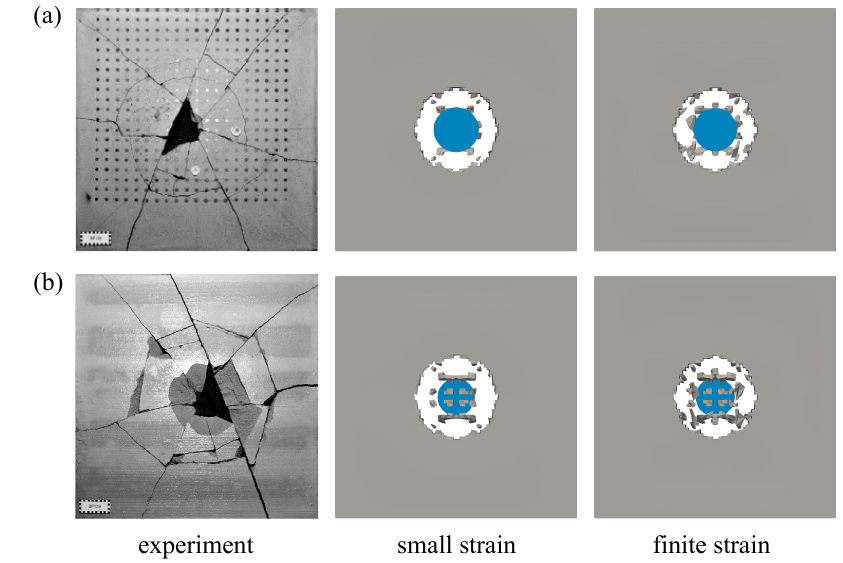
Figure 28. Damaged plate due to impact tests reported in [48] compared to small and finite strain simulations at the velocity of 12.3 m/s: ( a ) top view and ( b ) bottom